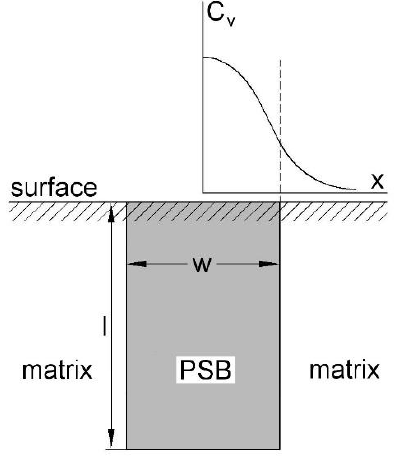
Figure 12. Schematic drawing of a PSB having the width w and the length l below the surface which is embedded in the matrix (artificially inclined 90 degrees to the surface). and the profile of vacancies migrating to the matrix and annihilated there at edge dislocations.